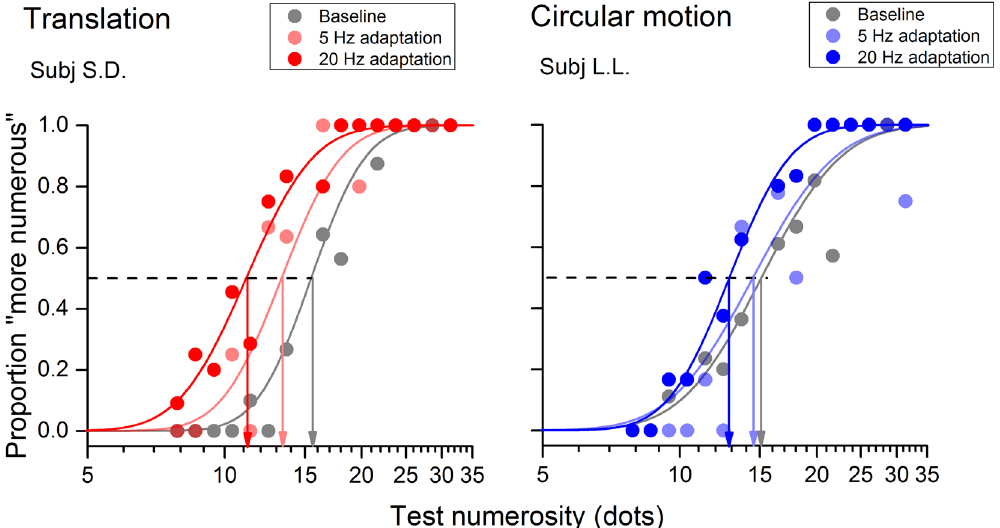
Figure 2. Psychometric functions for the numerosity discrimination task. Psychometric functions showing the proportion of trials where the test stimulus appeared more numerous than the reference stimulus as a function of the numerosity of the test. In each trial the numerosity of the test stimulus was chosen by means of an adaptive staircase procedure (see General procedure in Methods ), whilst the reference stimulus, presented in the adapted location, had always a fixed numerosity of 15 dots. The panel on the left refers to adaptation to translational motion and the panel on the right to adaptation to circular motion. Data in grey indicate the baseline condition in which the discrimination task was performed without adaptation. Data in light colour refer to conditions in which the adapting speed was slow (5 Hz) and full coloured lines refer to adaptation to fast motion (20 Hz). Despite the adapting motion profile being translational or circular, motion adaptation induced a compression of perceived numerosity as indicated by the leftward shift of the psychometric functions. However, adaptation to translational motion induced a much more robust compression of perceived numerosity to suggest a complex – motion profile-dependent – interaction between motion and numerosity